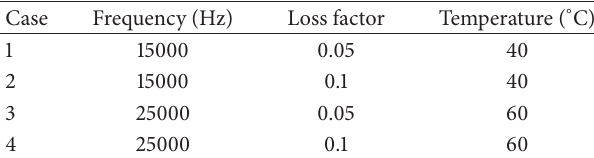
Table 3: Parameters for each